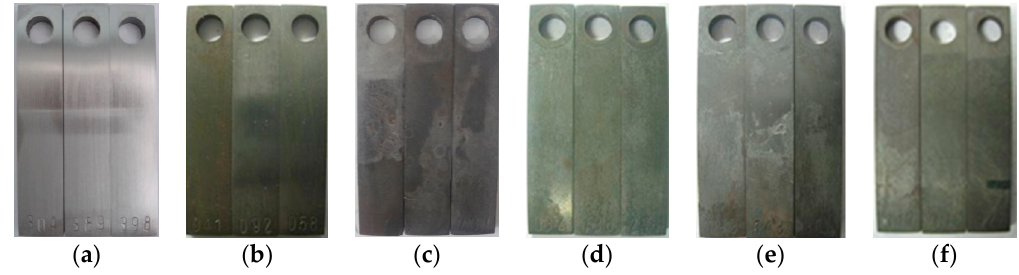
Figure 3. Macroscopic morphologies of J55 carbon steel before corrosion test: ( a ) before corrosion test and after the removal of corrosion scales under different CO 2 partial pressures; ( b ) Pco 2 = 0 MPa; ( c ) Pco 2 = 1.5 MPa; ( d ) Pco 2 = 5.0 MPa; ( e ) Pco 2 = 9.0 MPa; and ( f ) Pco 2 = 15.0 MPa.